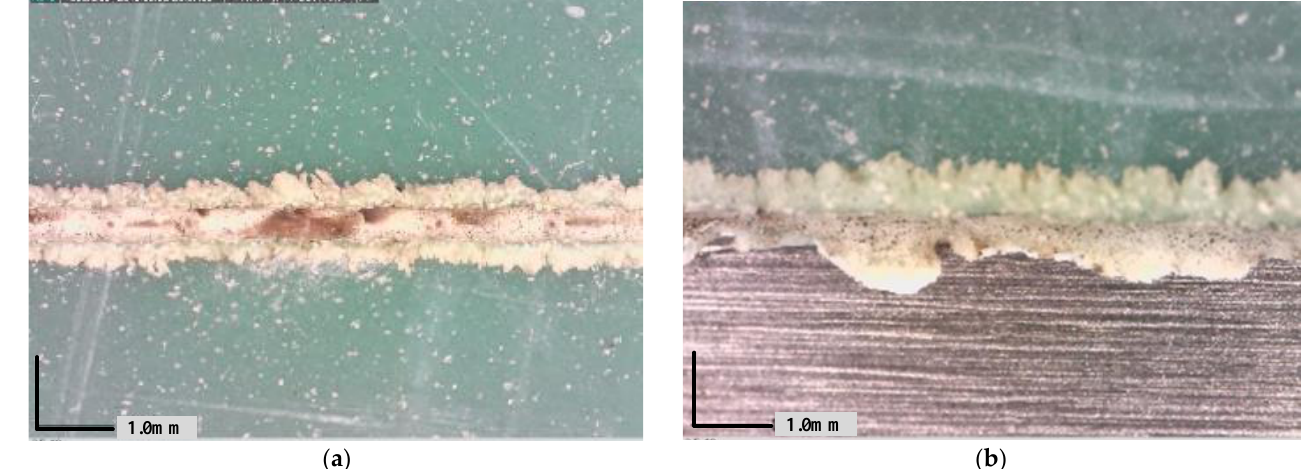
Figure 8. The maskant incomplete cut. ( a ) Incomplete cut scribing line; ( b ) The scribing lines are not continuous and smooth.